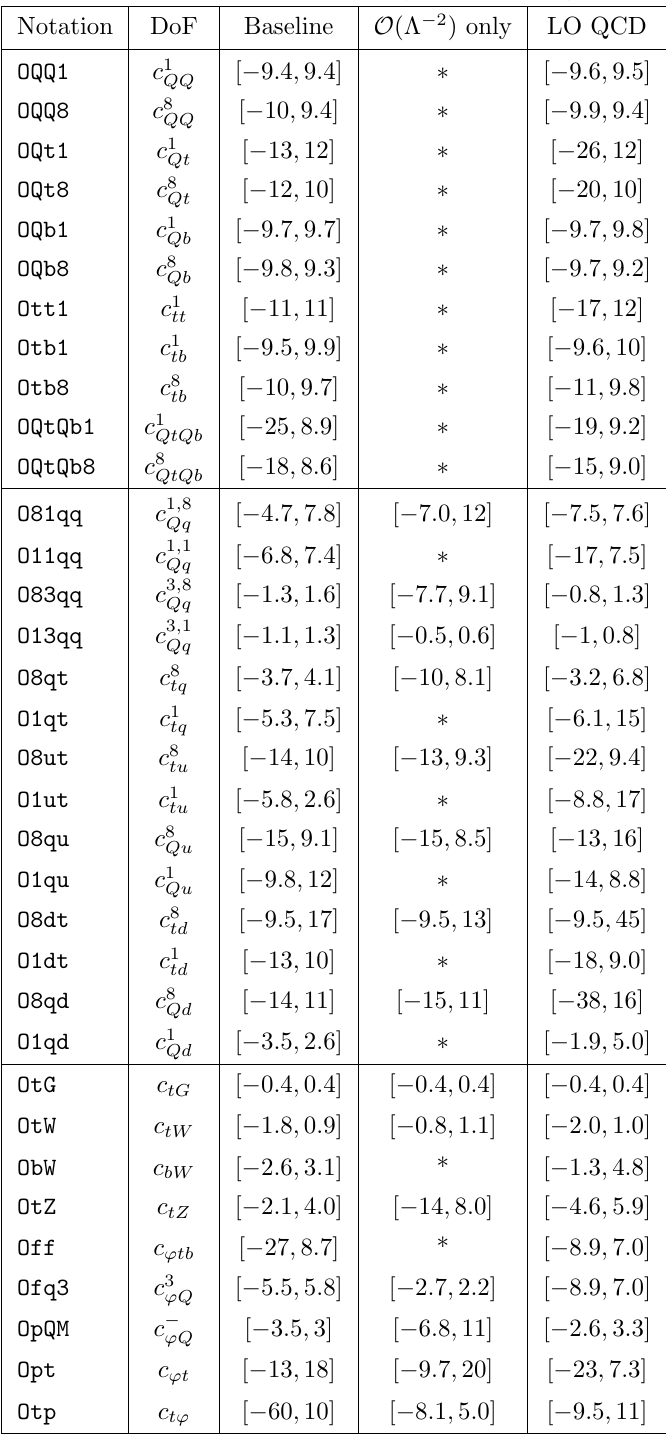
Table 9 . Same as table 8 for the 95% CL bounds obtained in the global (cid:12)t, now comparing the results obtained using the baseline theory settings with those obtained when only the linear terms are included and when only LO QCD calculations are used for the SMEFT contribution.